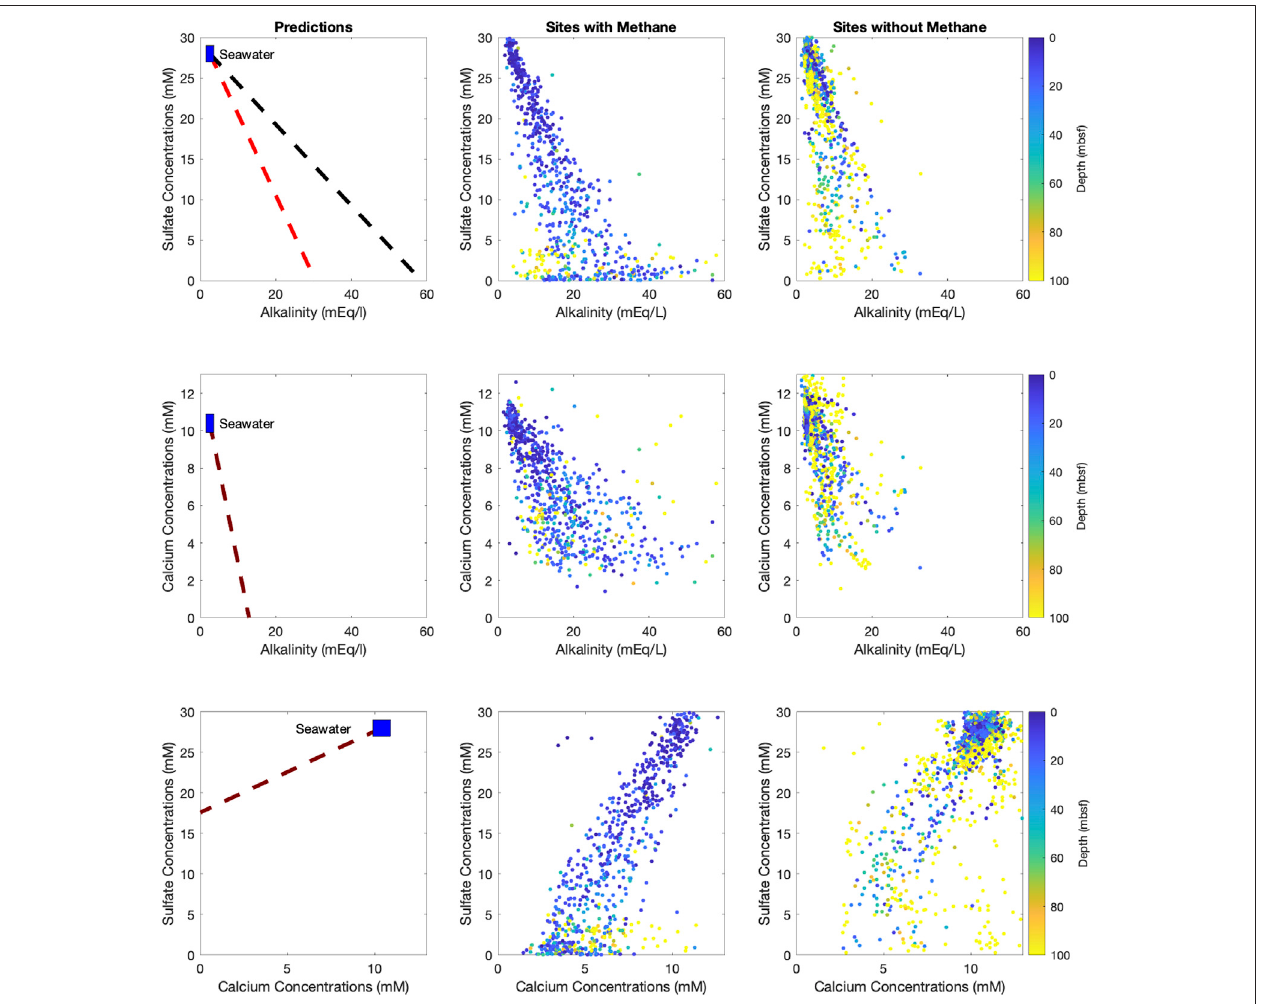
FIGURE 2 | Left column — predicted relationships between sulfate and alkalinity, with red denoting anaerobic methane oxidation and black denoting organoclastic sulfate reduction (top) , calcium and alkalinity (middle) and sulfate and calcium (bottom) based on the stoichiometry given in Eqs 1 – 7 . Middle and Right columns — the measured pore fl uid sulfate, alkalinity and calcium concentrations for sites where methane is present (middle) and where methane is absent (right) . The data in the middle and right columns are color-coded according to the depth of the sample, pore fl uid data deeper than 100 mbsf all plot in yellow.